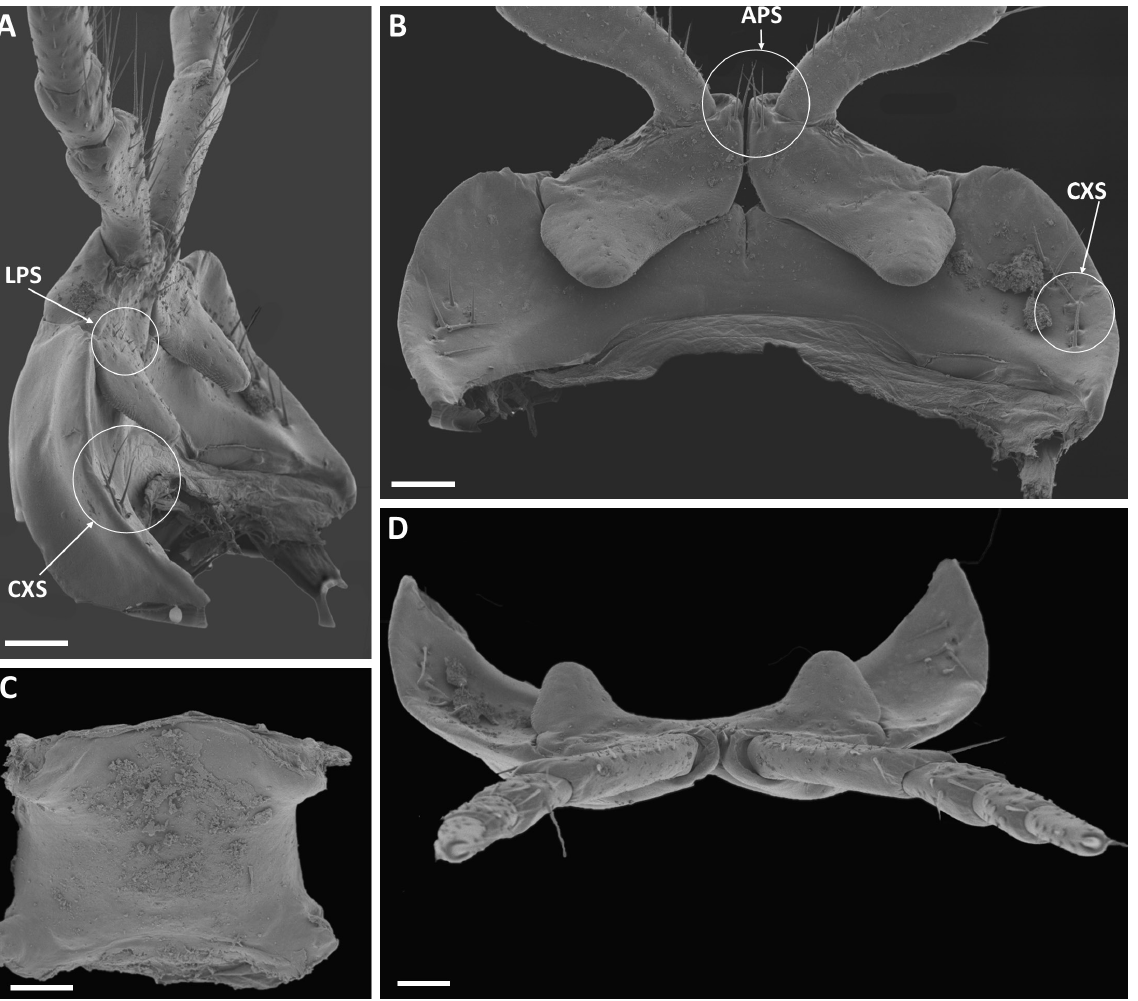
Fig. 37. Geotypodon cristinae sp. nov., holotype, ♂ (NHMD 621736). A–B, D . First pair of legs. C . Sternum 9. Abbreviations: APS = mesapical prefemoral setae; CXS = coxosternal setae; LPS = lateral prefemoral setae. Scale bars = 0.2